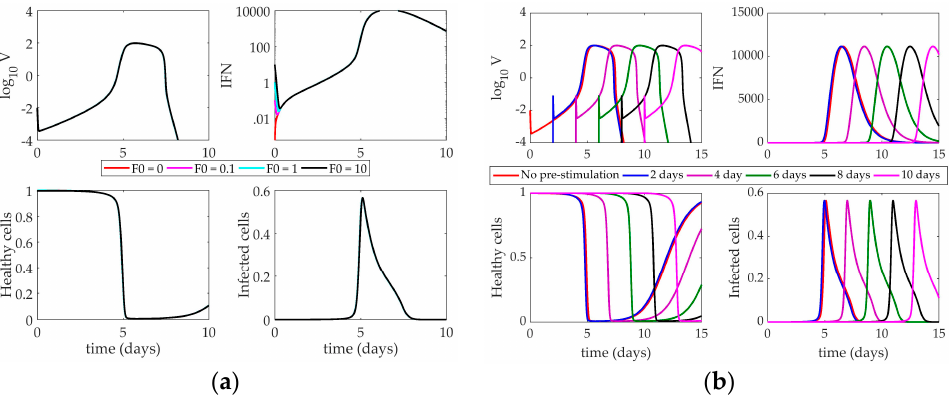
Figure 7 Figure 7. ( a ) Response of Hancioglu model to increasing IFN on day 0. Lines correspond to different values of F0 (initial condition of interferon); ( b ) Impact of IFN pre-stimulation scheduling on the Hancioglu model. IFN treatment is given on day 0 and patients are simulated to become infected 2, 4, 6, 8, or 10 days after